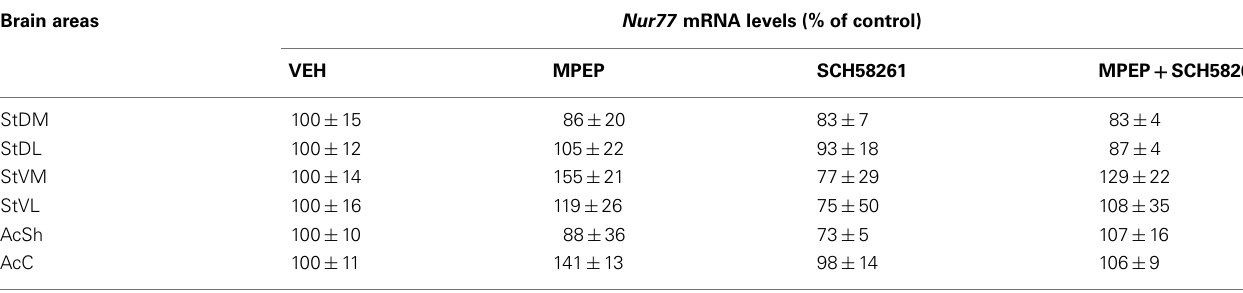
Table 1 | Nur77 mRNA levels following vehicle, MPEP, and SCH58261 in striatal subterritories. Brain areas Nur77 mRNA levels (% of